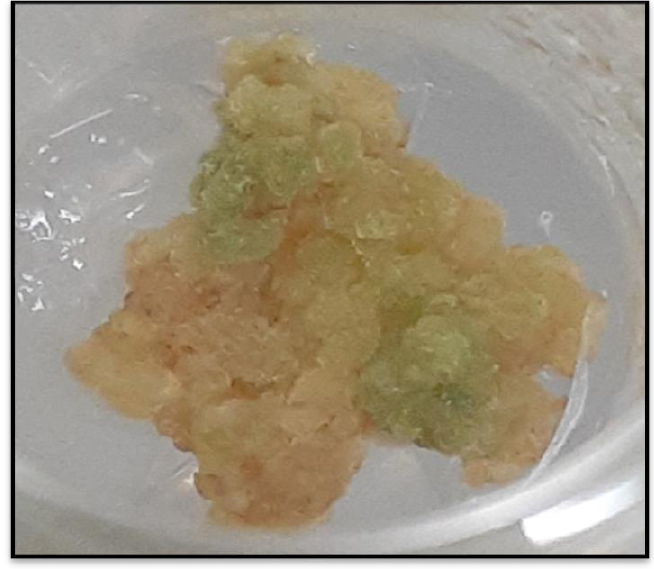
Fig1. Callus on the (MS) medium supplement with (2.0 mg. L-1 NAA with 0.5 mg. L-1